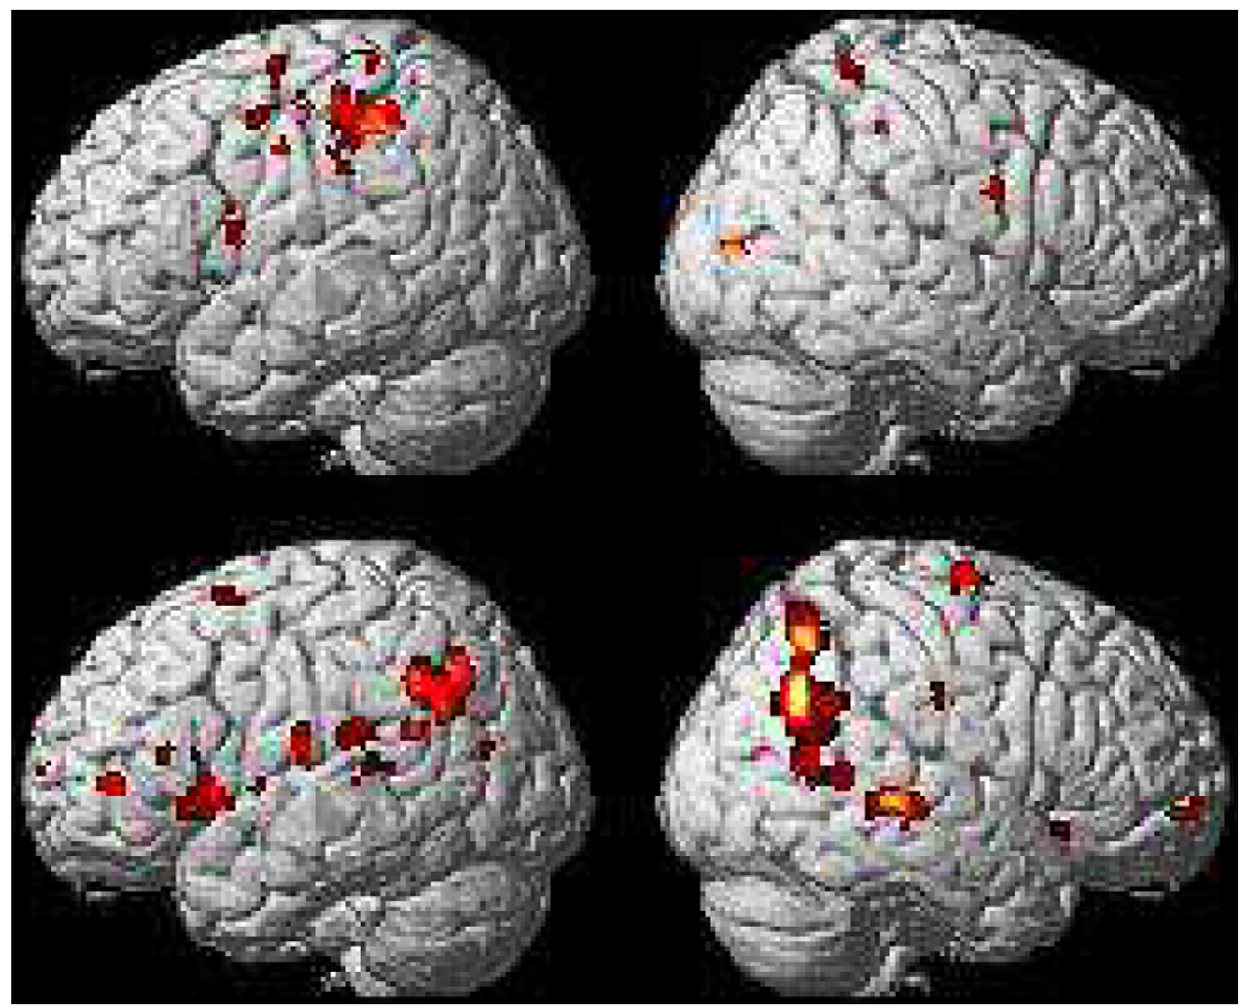
Figure 2. Object and event nouns masked by verb and vice versa. Nouns masked by verb show activations in the left insula ( 2 34 2 8 6; Z=4.59; BA 13L), left IFG ( 2 48 4 14; Z=3.98; BA 44L), left inferior parietal lobule ( 2 42 2 32 46; Z=4.92; BA 40L), left anterior cingulate cortex ( 2 20 18 32; Z=3.87; BA 32L), and right middle temporal gyrus (40 2 82 8; Z=5.07; BA 39R). Verb masked by nouns shows activations of interest in the left hemisphere ( 2 44 18 0; Z=4.18; BA 13L), left IFG ( 2 32 26 2 6; Z=3.45; BA 47), ( 2 42 42 6; Z=4.25; BA 46), ( 2 48 26 14; Z=3.58; BA 46), ( 2 8 66 8; Z=3.71; BA 10), left ACC ( 2 20 48 8; Z=4.41; BA 32L), the left IPL and superior temporal gyrus ( 2 48 2 52 22; Z=3.92; BA 40L. 2 66 2 42 10; Z=4.68; BA42L. 2 58 2 16 18; 3.99; BA 43L. 2 60 2 2 6; Z=3.24; BA 22L), and the right hemisphere (38 20 2 10; Z=3.51; BA 47R. 28 56 2 4; Z=3.36; BA 10R. 64 2 28 2 2; Z=5.07; BA 22R).